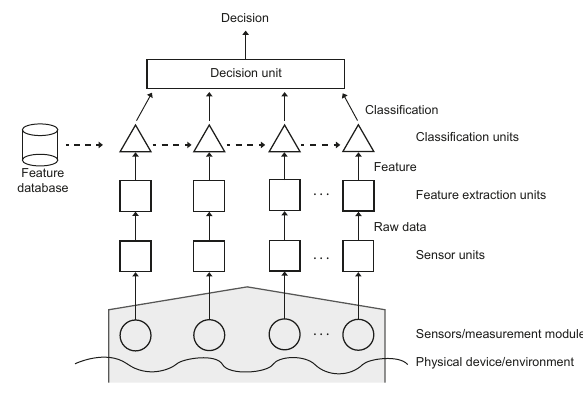
Figure 1. Multimodal